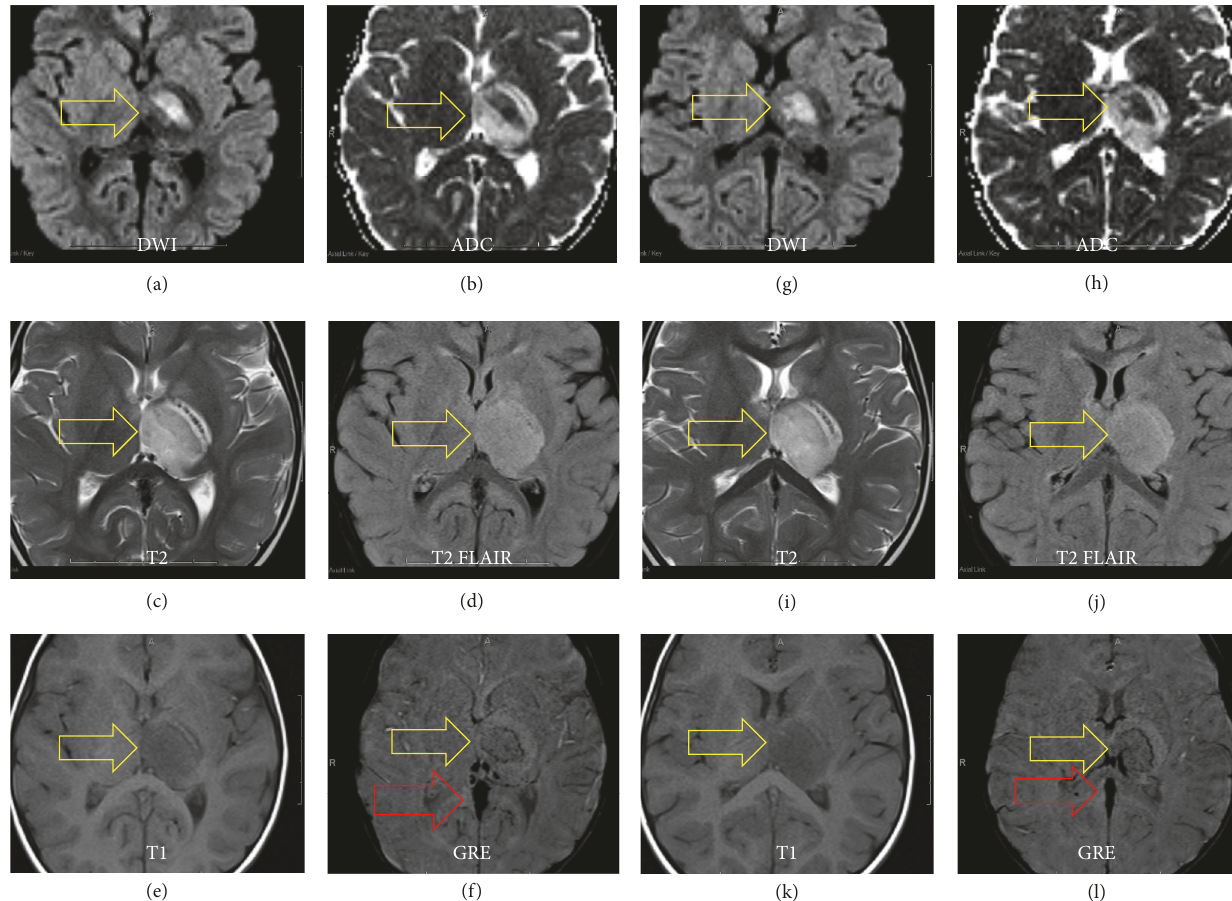
Figure 2: MRI obtained to confirm deep cerebral venous thrombosis and left thalamic infarction. DWI and ADC imaging ((a), (b), (g), and (h)) shows restricted diffusion in the anteromedial left thalamus without distinct territorial boundaries in relation to venous ischemia. T2 FLAIR hyperintensity ((c), (d), (i), and (j)) shows surrounding edema related to the infarction. GRE image (f) shows dark signal loss suggestive of petechial hemorrhage around the area of ischemia. GRE image (l) shows linear signal drop in the posteromedial surface of the left thalamus, highly suggestive of thrombus within a venous structure, likely part of the left internal cerebral